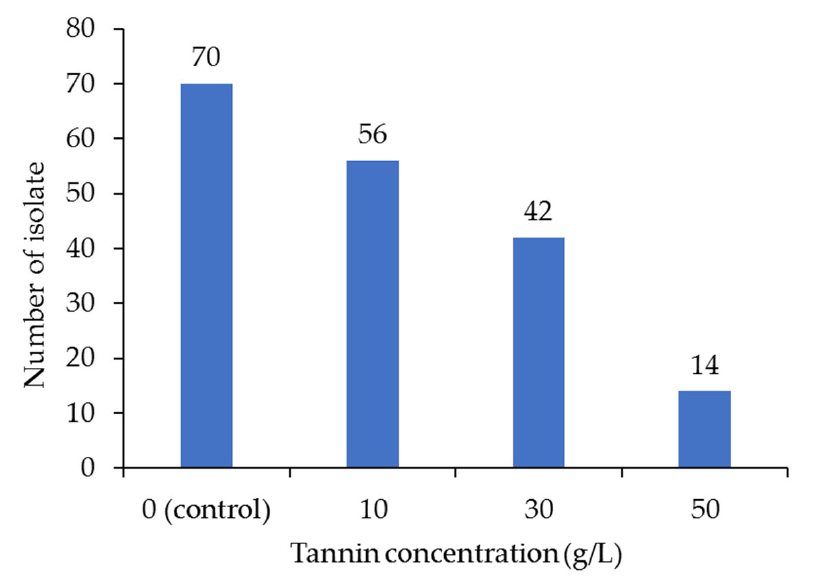
Figure 5. Number of bacterial endophytes from tea leaves with tannin tolerance capacity after cultivation on nutrient agar supplemented with 10, 30, and 50 g/L tannic acid at 30 °C for 72 h.